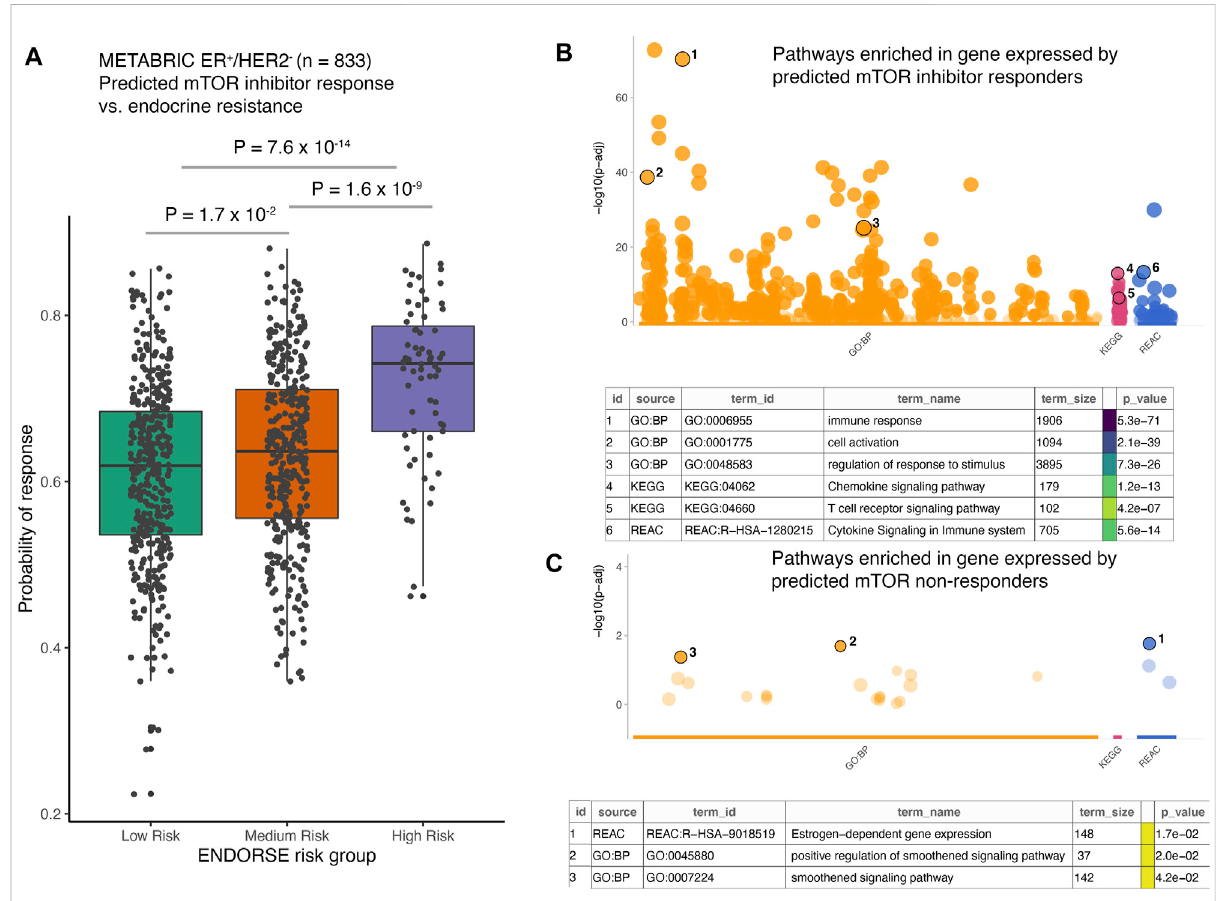
FIGURE 5 Application of the mTOR inhibitor model on external dataset. (A) The boxplots show predicted probability of mTOR inhibitor response in METABRIC ER+/HER2- patients ( n = 833). The patients were classi fi ed as endocrine sensitive (low-risk), endocrine intermediate (medium-risk) and endocrine resistant (high-risk) using the ENDORSE model. The adjusted p -values annotated above the boxplots show pairwise comparisons obtained from Tukey ’ s HSD test applied to a one-way ANOVA model (B,C) . The dotplots show signi fi cance of the enrichment terms from GO: BP, KEGG and REACTOME signatures, with Y-axis showing -log10 of the FDR-adjusted p -value from the enrichment test. Key signi fi cant terms enriched in genes that were (B) expressed at higher levels in the tumors predicted to be responsive to mTOR inhibitor treatment or (C) expressed at higherlevelsinthetumorsnon-responsivetomTORinhibitortreatmentareannotatedinthetablebelow.Thetermsizeindicatednumberofgenesin theoriginalsignature,whilethecolorcodeindicatesstrengthofevidenceassociatedwiththeterm.Termssupportedbyweakevidenceareshownin blue while experimentally derived signatures are shown in